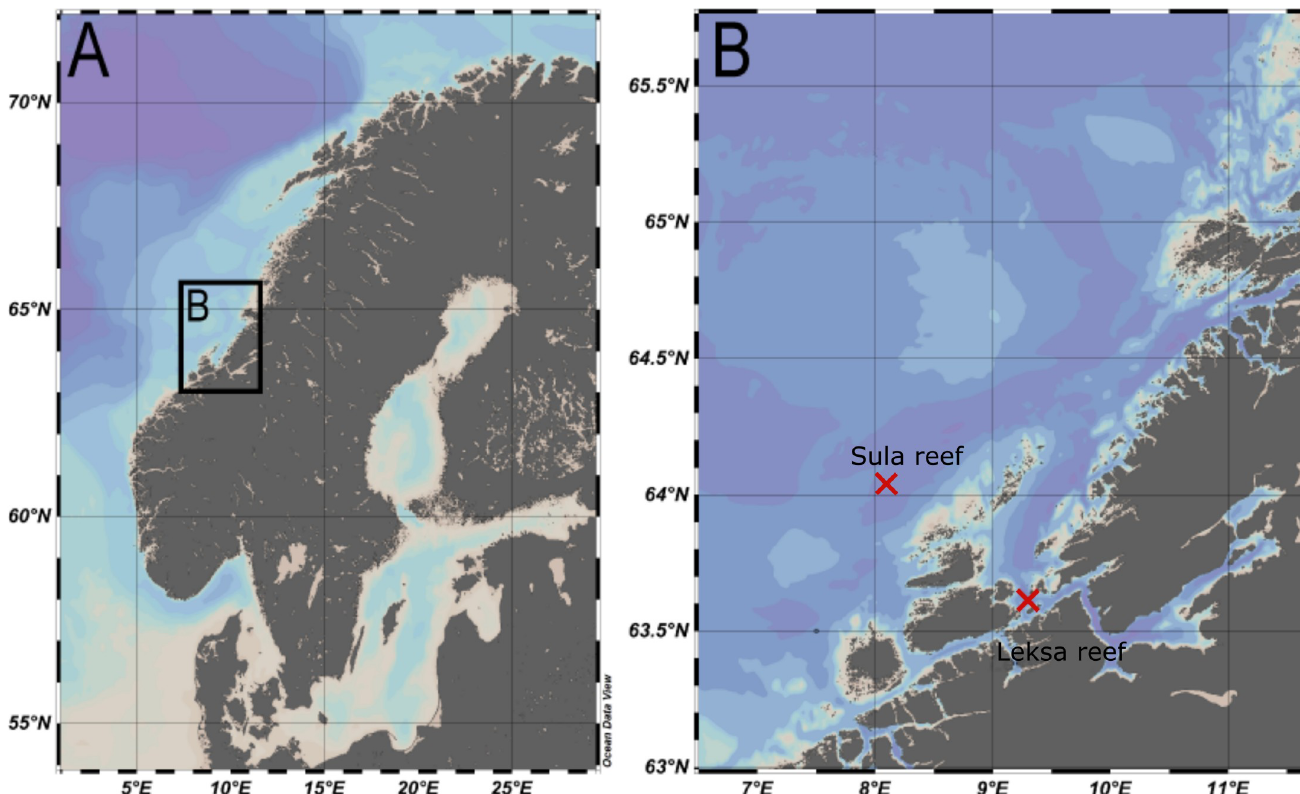
Fig 1. Map of the sampling locations. A. Overview of the Fennoscandian Peninsula. B. Enlarged section of the sampling locations.